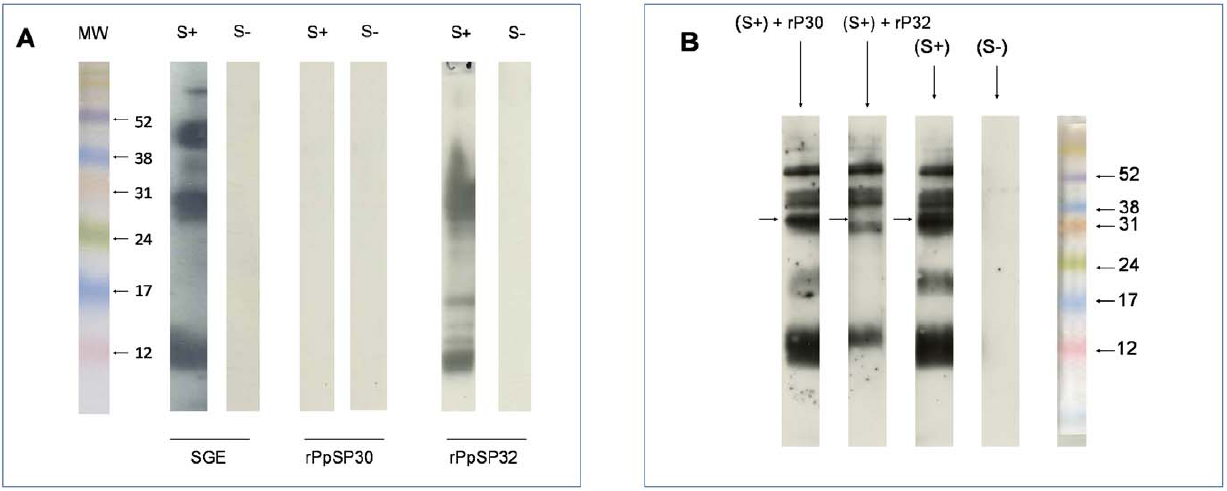
Figure 7. Western blot analyses of native and recombinant salivary proteins. ( A ) Salivary gland extract (SGE) as well as the recombinant forms of PpSP30 (rPpSP30) and PpSP32 (rPpSP32) were run on a 15% SDS-PAGE gel. Western blot analysis was performed with positive (S + ) and negative (S 2 ) human sera from donors living in areas with high prevalence of P. papatasi . Results are representative of three independent experiments. ( B ) Sera tested positive with IgG anti-SGE were pre-incubated with the recombinant proteins PpSP32 and/or rPpSP30 at 10 m g/ml and then tested in Western blot against SGE. Results are representative of three independent experiments. The arrows indicate the emplacement of the immunodominant protein.